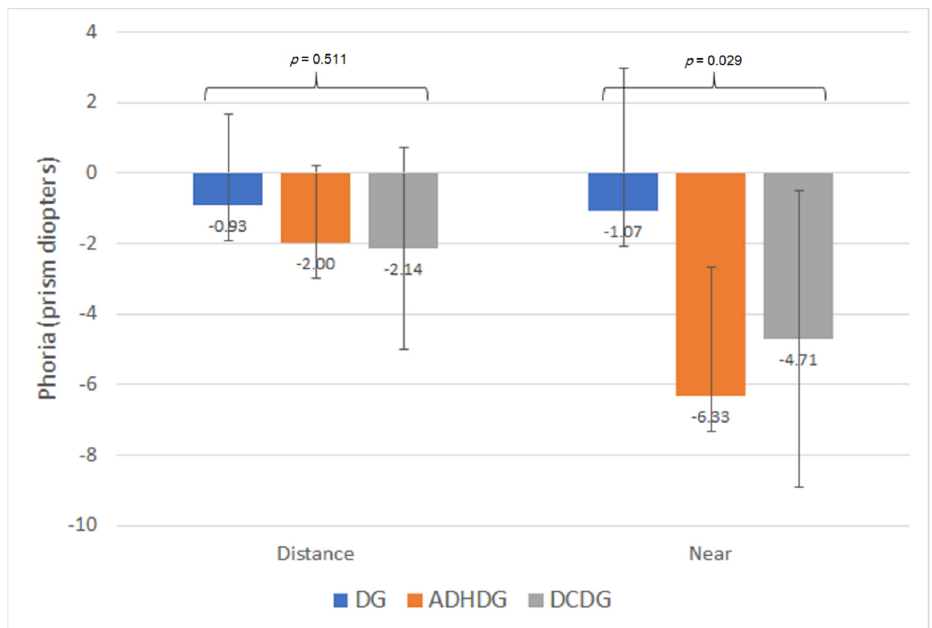
Figure 2. Mean values for the break and recovery points of the near point of convergence (NPC) in the subgroups of dyslexia (DG), attention deficit/hyperactivity disorder (ADHDG) and developmental coordination disorder (DCDG).